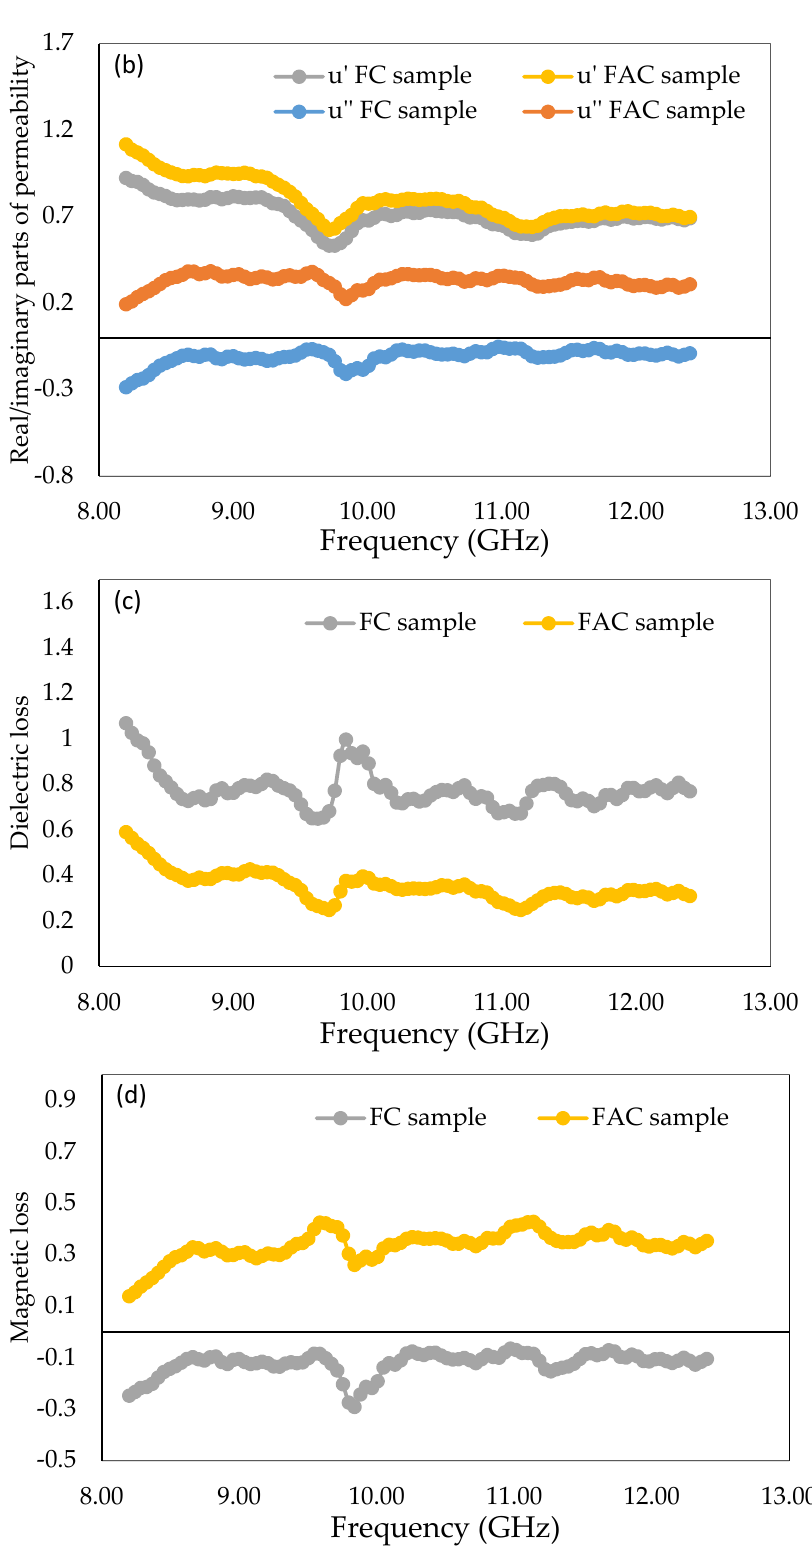
Figure 8. Electromagnetic parameters of FC and FAC samples: ( a ) real/imaginary parts of permittivity, ( b ) real/imaginary parts of permeability, ( c ) dielectric loss; ( d ) magnetic loss.